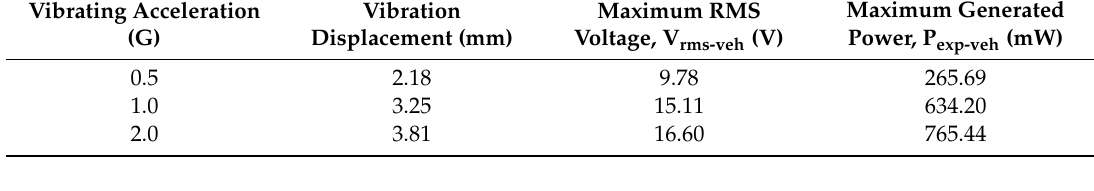
Figure 13. The RMS generated voltage with a 360 Ω load resistance (V rms-veh ) according to the vibration acceleration at one lower coil of the VEH device. A resonant frequency of 50 Hz was used under 0.5, 1.0 and 2.0 G vibration acceleration conditions. The thickness of the spring was 1.0 mm. The maximum moving displacement of the spring was 4.0 mm.